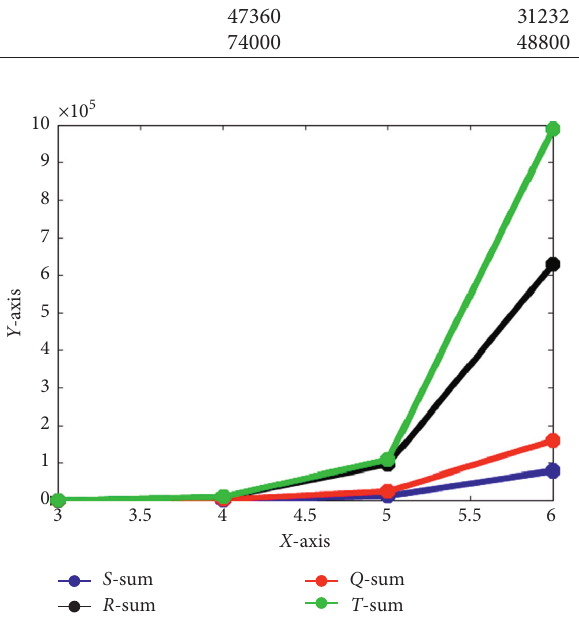
Figure 4: Graphical representations for Table